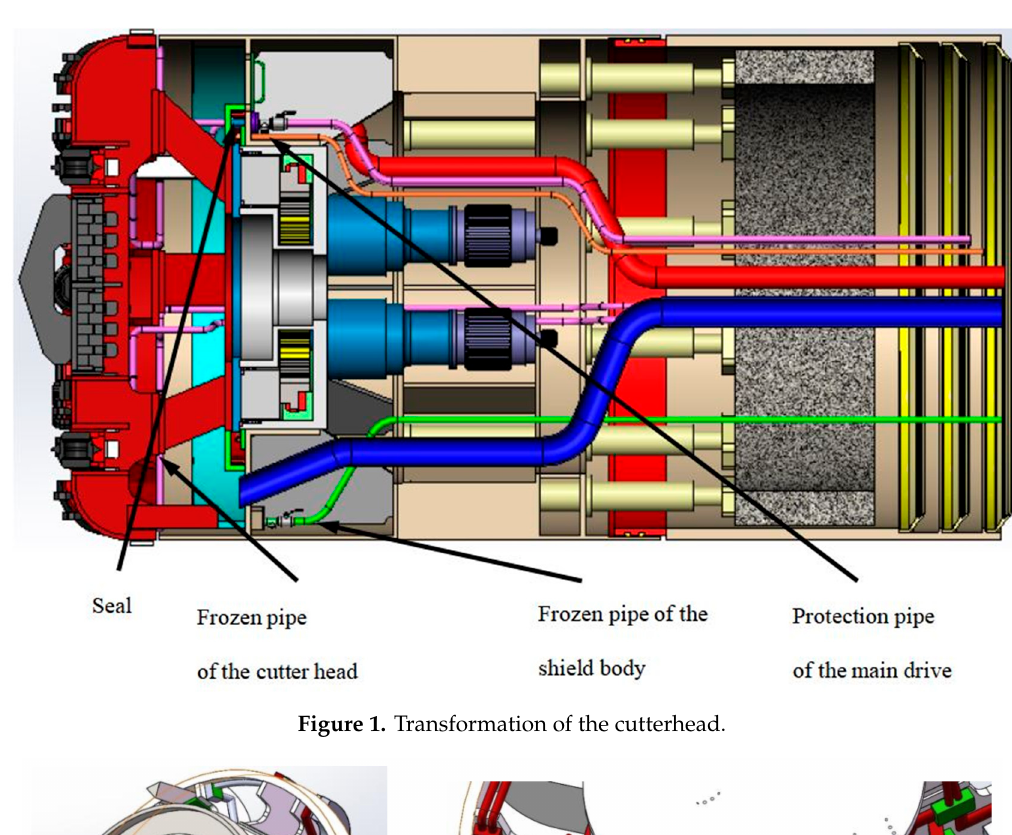
Figure 1. Transformation of the cutterhead.